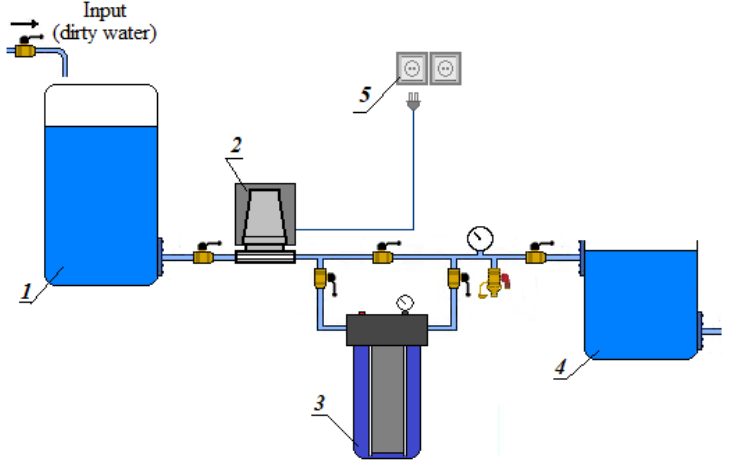
Figure 1. Treatment plant setup: 1—initial water tank; 2—pump; 3—zeolite filter; 4—storage tank; 5—power supply.